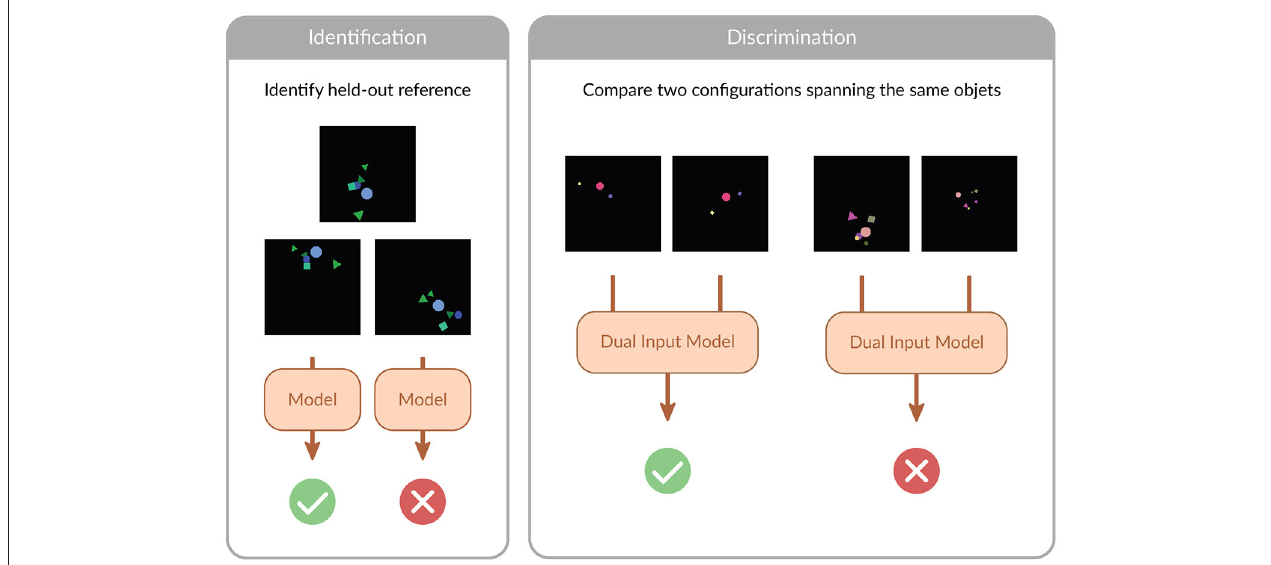
FIGURE 1 | Visual illustration of SpatialSim. The benchmark is composed of two tasks, Identification and Discrimination. In Identification, the model is tasked with predicting whether a given configuration is the same as a held-out reference one, up to rotation, translation and scaling. In Discrimination, a dual-input model is tasked with recognizing whether a given pair of configurations is the same up to rotation, translation and scaling. We represent visual renderings of our objects, but note that for all objet-based models we consider the object-based representation is used as input: see main text.